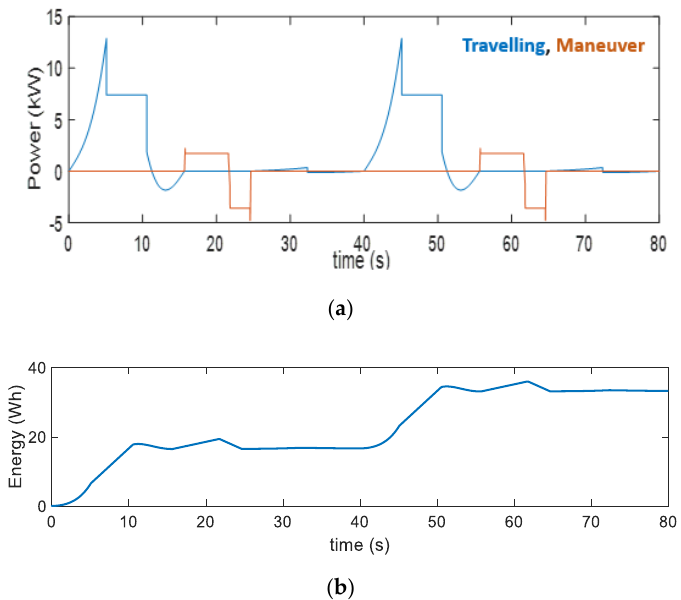
Figure 6. ( a ) Power and energy requested from the VDI drive cycle—(blue) traction power (red) lifting power, ( b ) Energy requested from the VDI drive cycle—(blue) total energy from traction and lifting power.